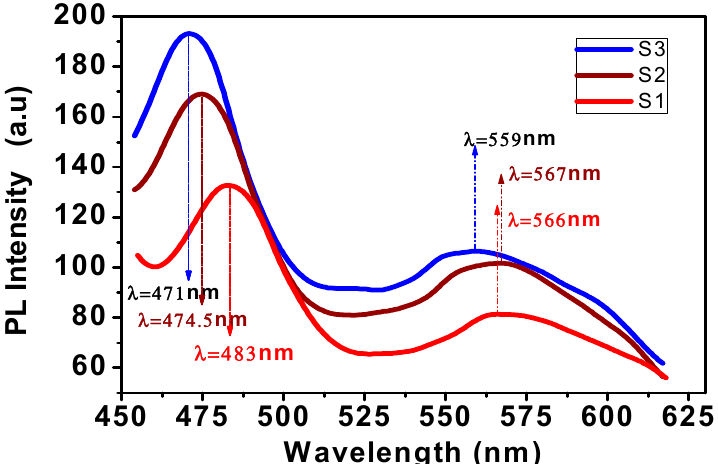
Figure 2. The plasmonic response of the three samples S1, S2, and S3, measured by photoluminescence (PL) spectroscopy and their corresponding resonance wavelengths.